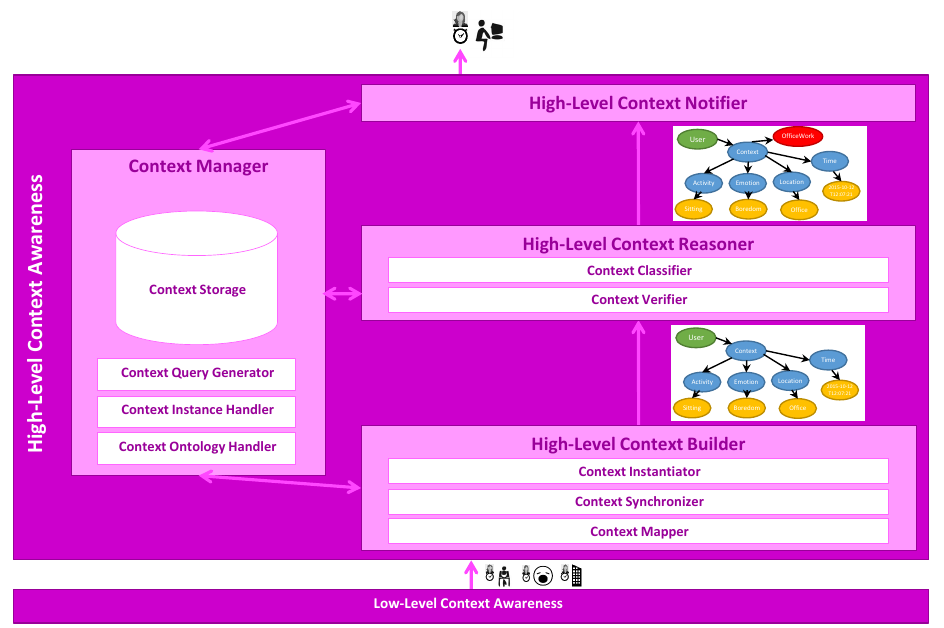
Figure 3. High-Level Context Awareness operation